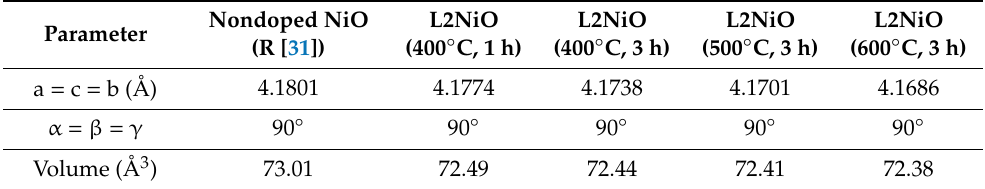
Table 1. Refined values of the L2NiO thin films with di ff erent annealing temperatures and times.